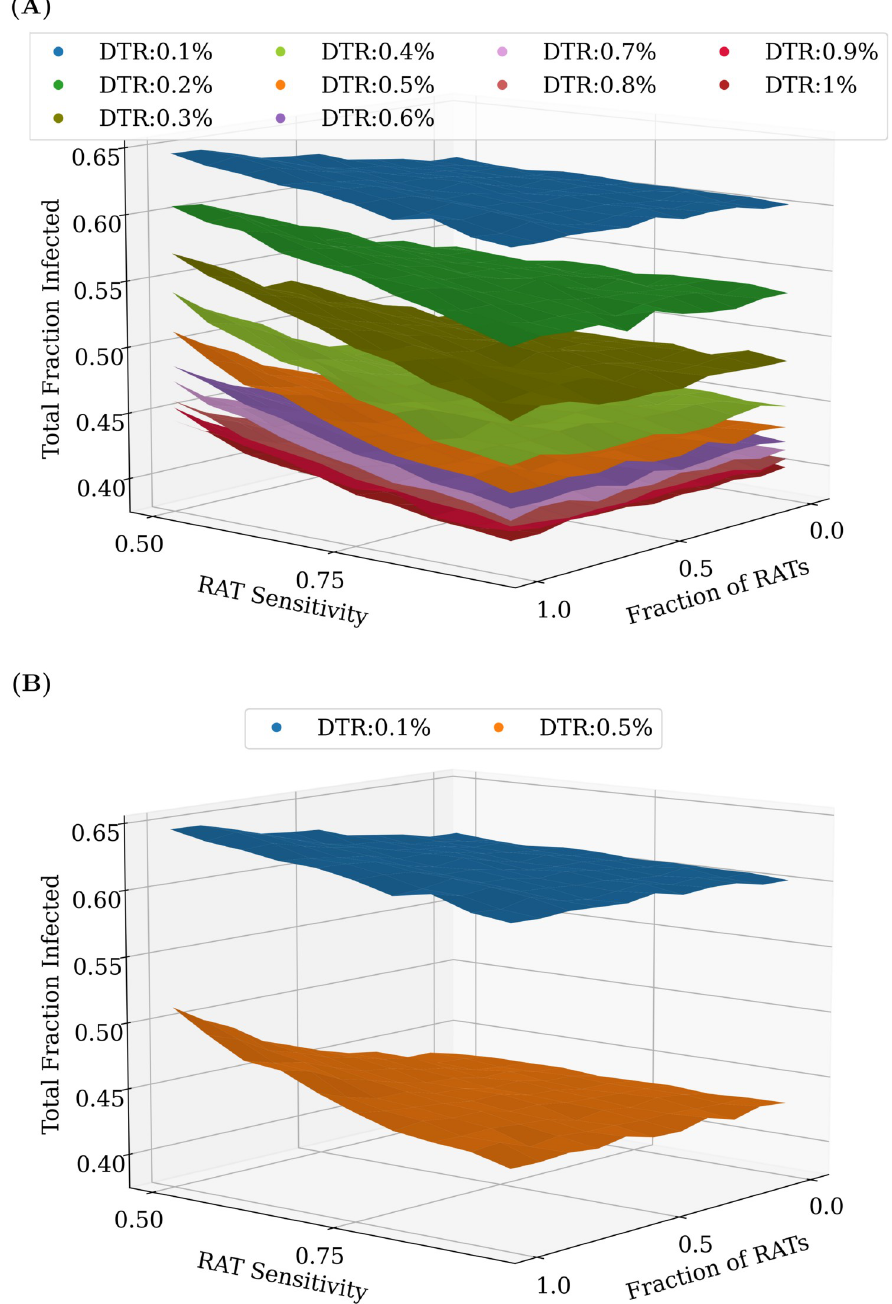
Fig 7. Comparing different test mixtures across a range of testing rates. An increase in the overall daily testing rate causes a large decrease in the total fraction of infected. (A) shows the effect of varying testing rates between 0.1% and 1% of the population per day, while (B) only shows 0.1% and 0.5% daily testing rates (the same as in Fig 6). In most cases, even at RAT:PCR mixtures of 80:20, good results can be obtained. As before, the plots were obtained by averaging over 100 simulation runs of 200 days